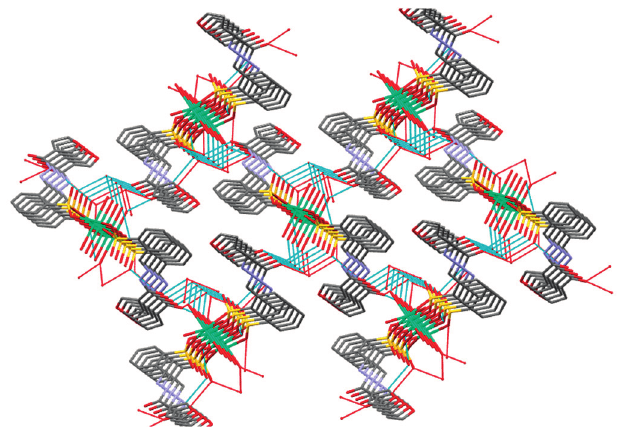
Figure 3. 1D chained structure of 1 .